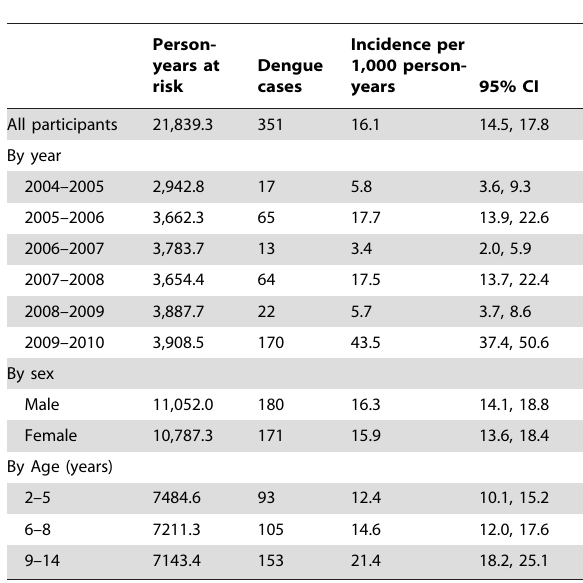
Table 2. Incidence of dengue cases, Managua, Nicaragua, 2004–2010.